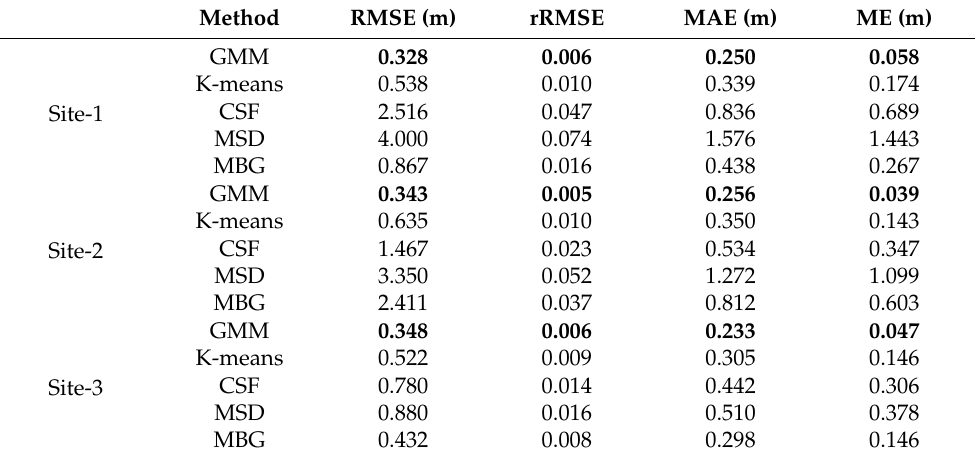
Table 2. Vertical accuracy assessment on ground identification. Bold numbers indicate the best results. Method RMSE